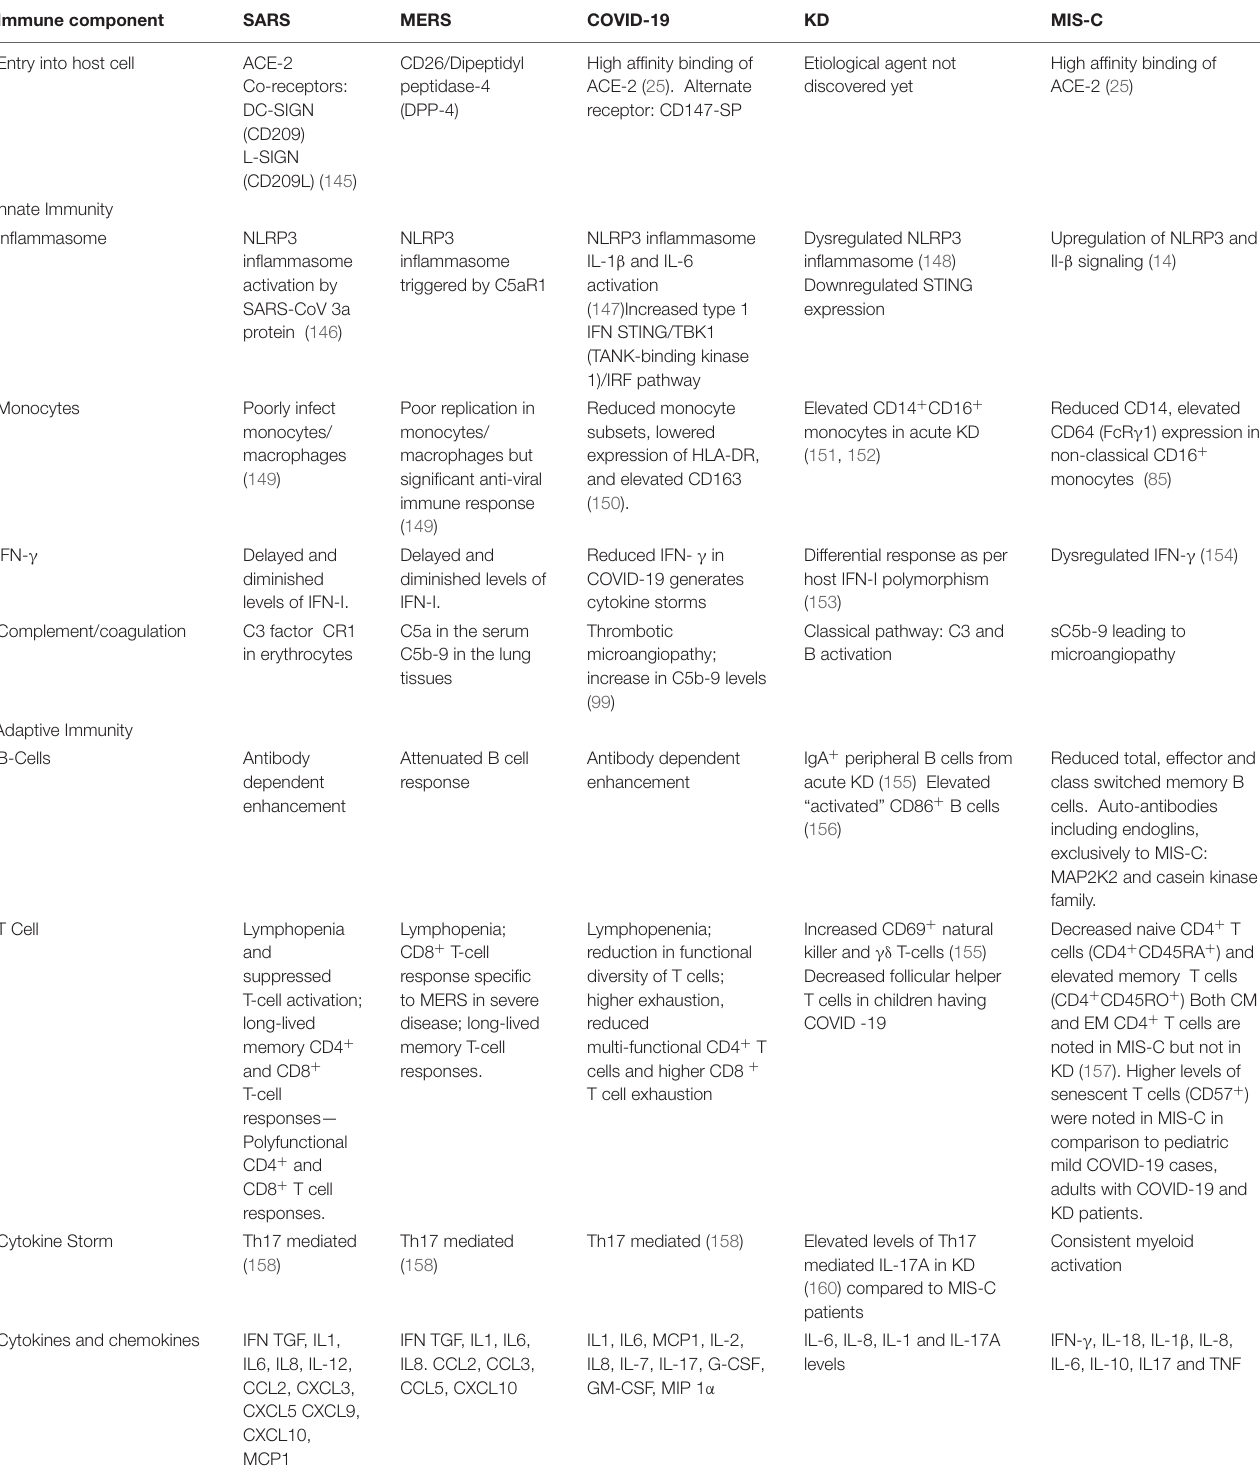
TABLE 4 | Immune mechanisms operative in SARS-MERS-COVID-19 infections and KD/MIS-C. Immune component SARS MERS COVID-19 MIS-C